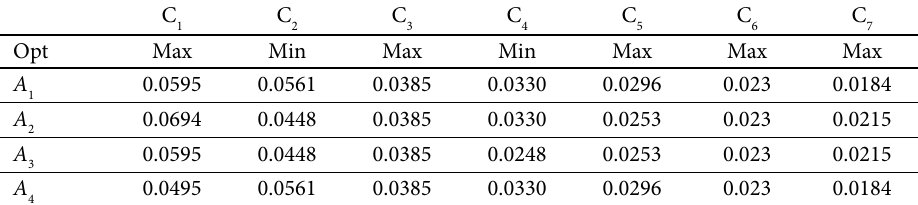
Table 5. Weighted normalized matrix